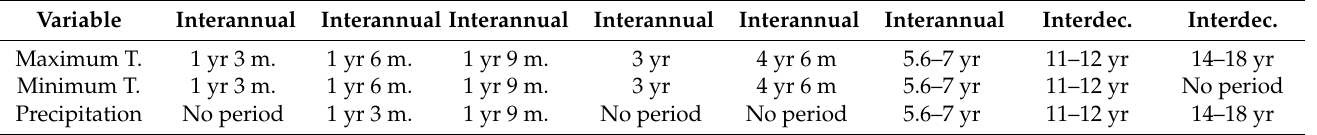
Table 4. Identified periodicities for each meteorological variable in interannual and interdecadal